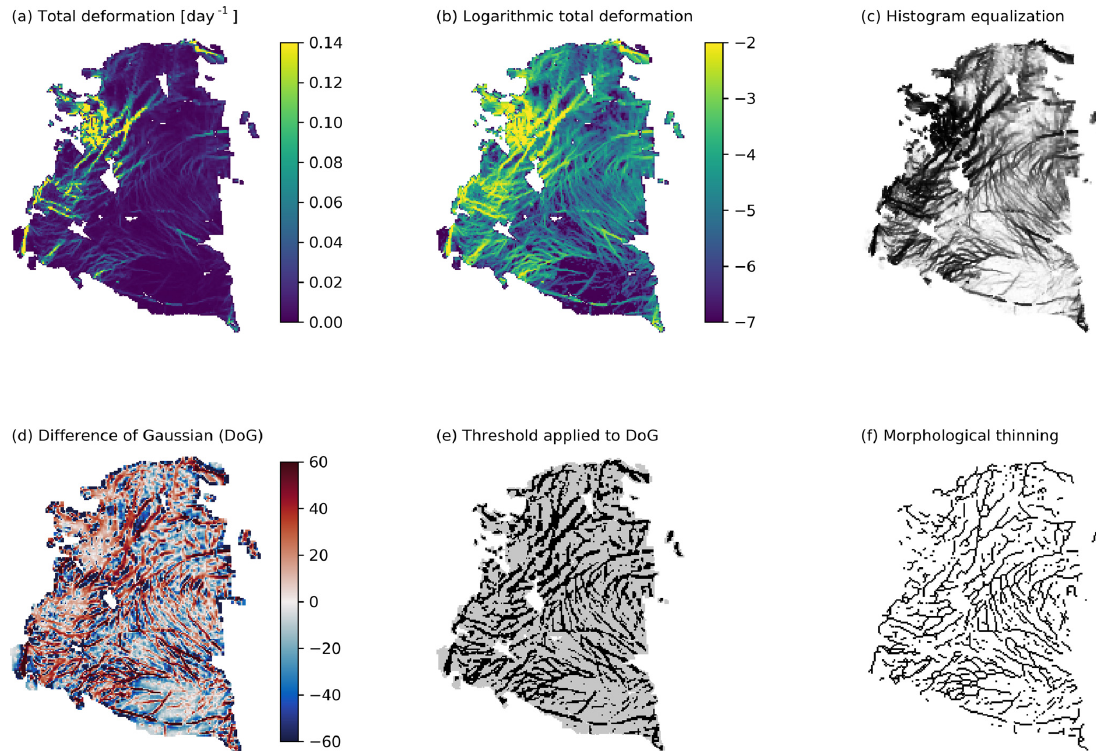
Figure 1. Filter sequence from (a) input field total deformation to (f) final output of the morphological thinned binary map of LKF pixels. Intermediate steps are (b) logarithmic deformation, (c) histogram equalization, (d) difference of Gaussian filter, and (e) the thresholded output of the DoG filter. RGPS deformation data for 1 January 2006 are used for this